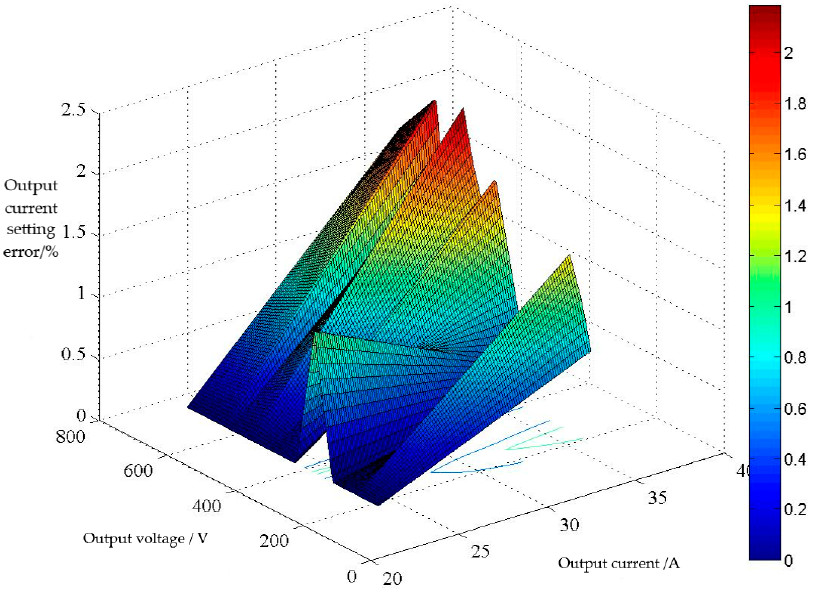
Figure 3. Output current setting error test result diagram.